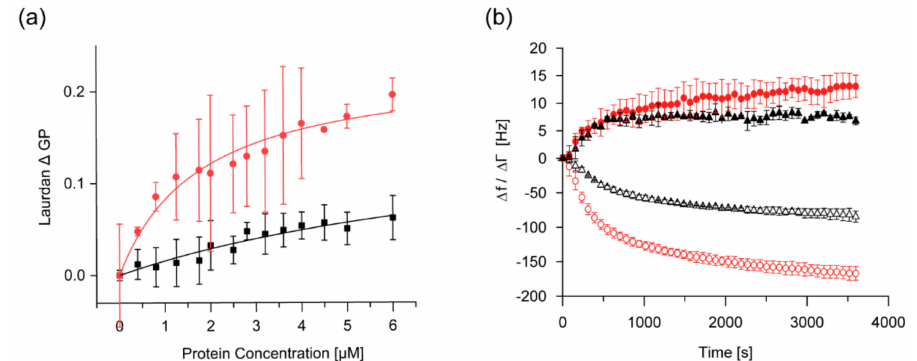
Figure 4. IM30 membrane binding is enhanced at low pH. ( a ) Steady-state membrane binding of IM30 was measured using Laurdan fluorescence spectroscopy at pH 5.5 (red) and pH 7.6 (black). The Laurdan ∆ GP at 100 µ M lipid (40% DOPG / 60% MGDG) with 0–6 µ M IM30 was strongly increased at pH 5.5. The membrane-binding a ffi nity of IM30 at pH 7.6 is characterized by a K d = 9.8 ± 5.8, and at pH 5.5 by a K d = 1.8 ± 0.4 ( n = 3, error bars = SD). ( b ) Kinetics of IM30 binding (4.5 µ M) to a solid-supported bilayer (20% DOPG / 80% DOPC) was monitored using QCM-D at pH 5.5 (red) and pH 7.6 (black), respectively. Empty symbols represent the change in frequency ( ∆ f), filled symbols represent the change in damping ( ∆ Г ). At pH 5.5, faster binding kinetics reflected by the change in frequency ∆ f was observed ( n = 3, error bars =